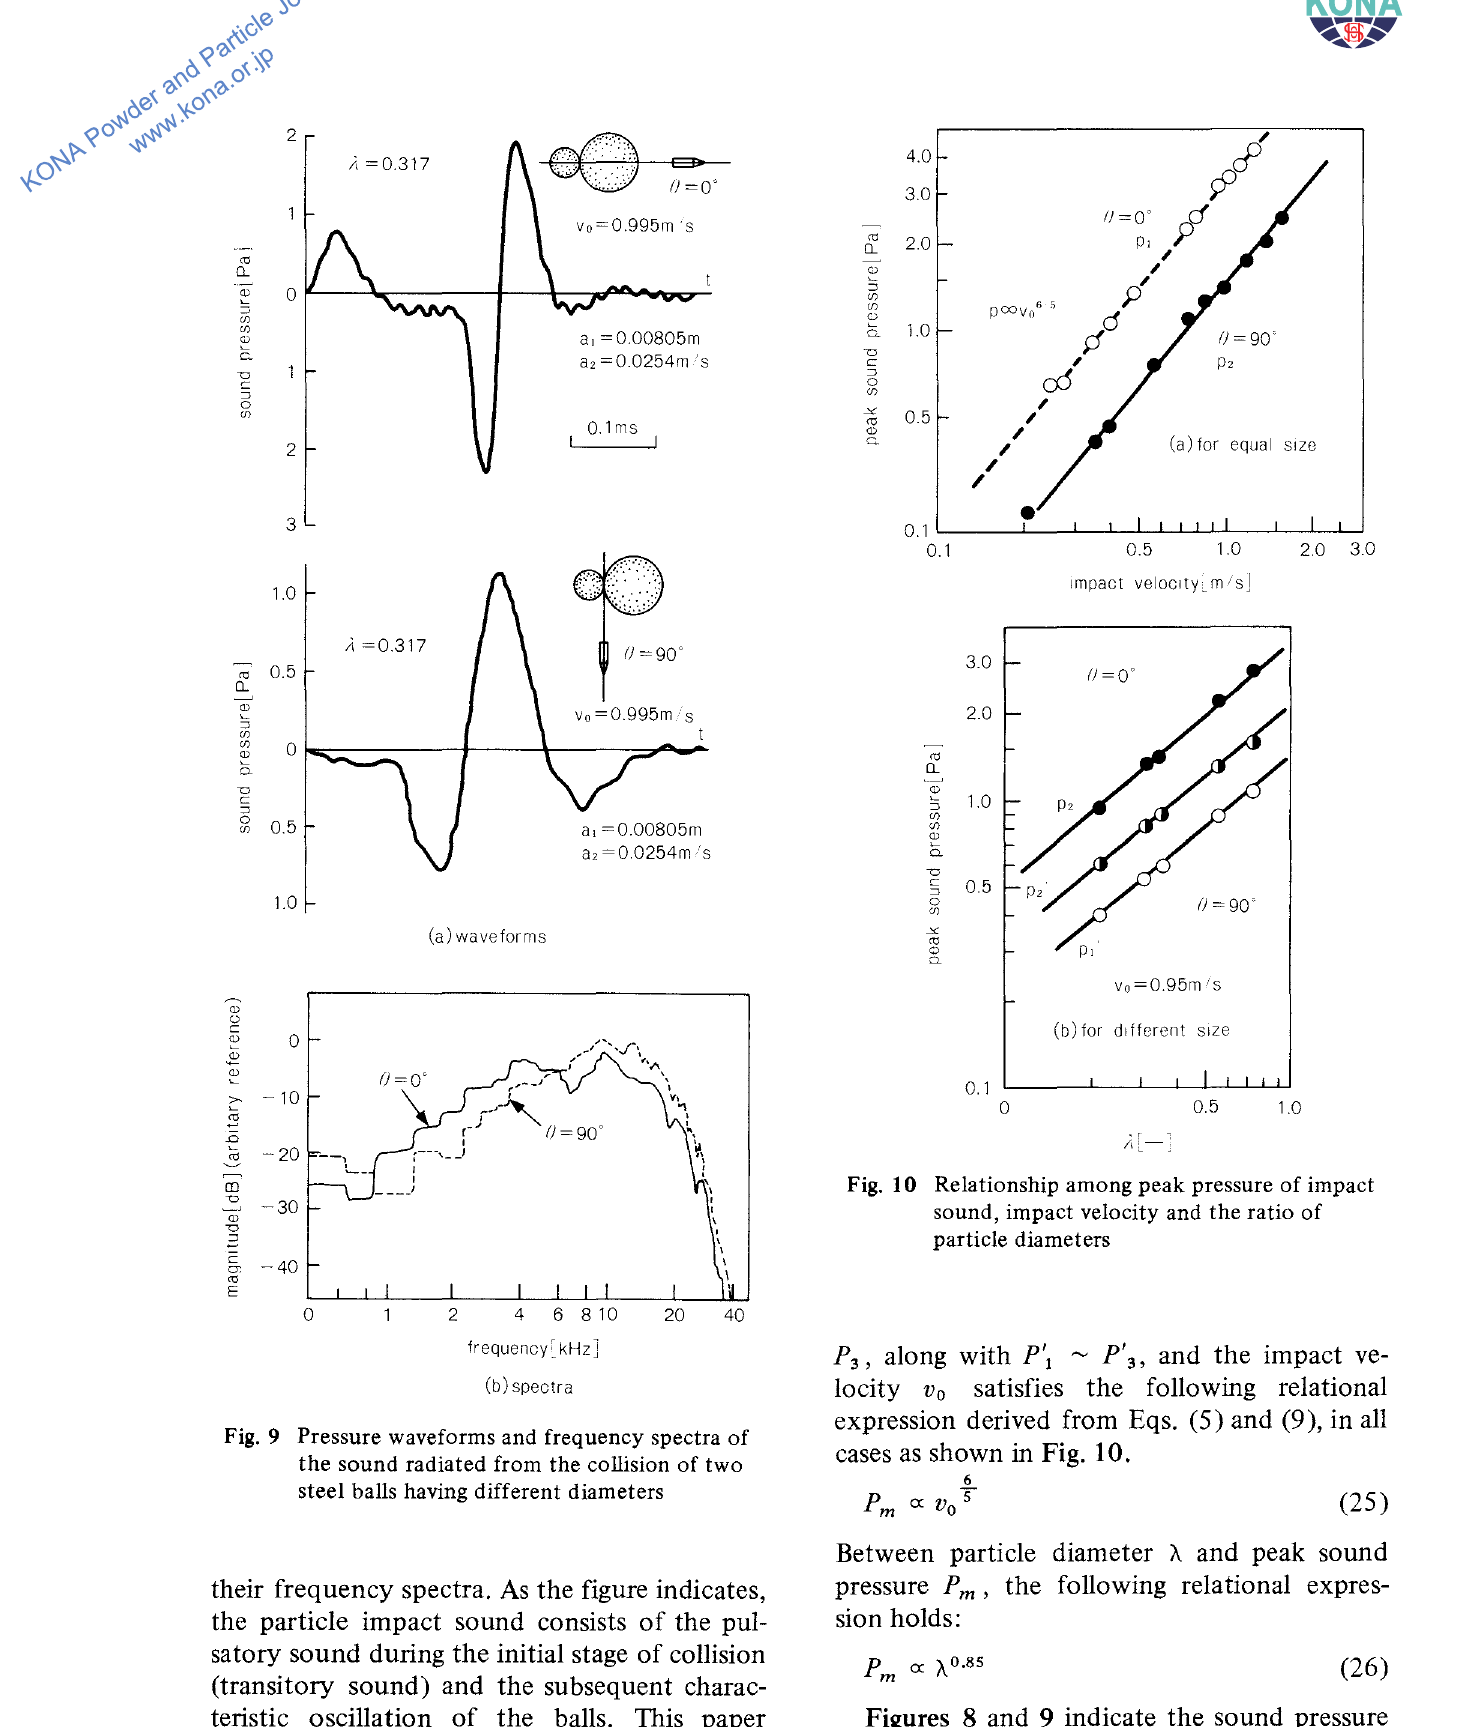
Fig. 9 Pressure waveforms and frequency spectra of the sound radiated from the collision of two steel balls having different diameters